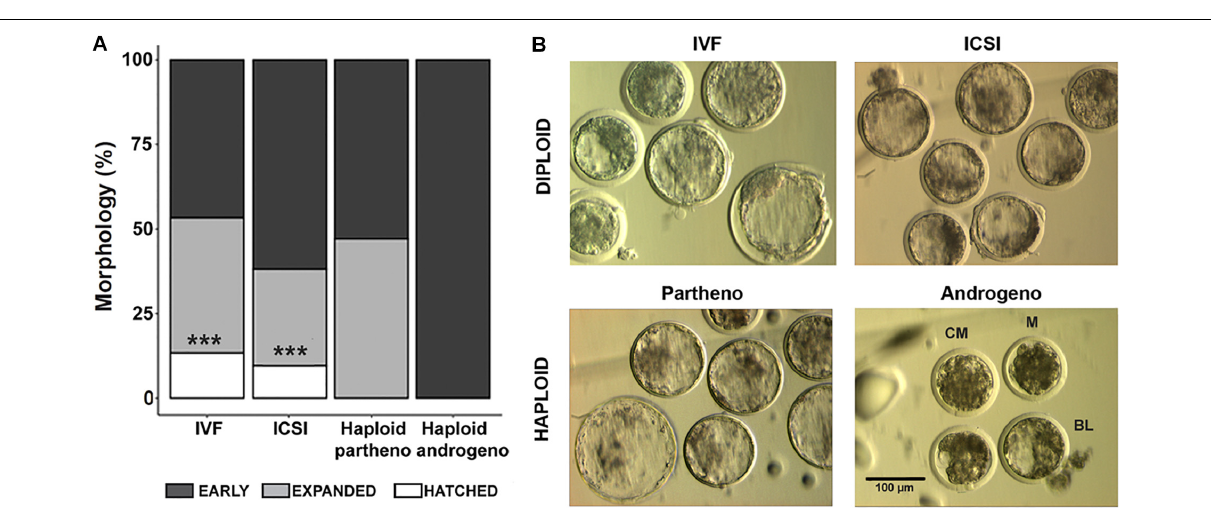
FIGURE 3 | Morphological assessment of haploid and diploid embryos at Day-7 (168 h) of culture. (A) Percentage of differing blastocyst stages. (B) Representative images of the most advanced embryos from different controls and haploid groups. IVF, in vitro fertilized; ICSI, intracytoplasmic sperm injection using female-sorted semen; Haploid partheno, haploid parthenogenetic embryos obtained by oocyte activation using ionomycin followed by cyclohexymide; haploid androgeno, haploid androgenetic embryo obtained by ICSI + oocyte enucleation. M, compact morula; CB, cavitating blastocyst; BL, blastocyst. ∗∗∗ p < 0.001. Scale bar = 100 µ